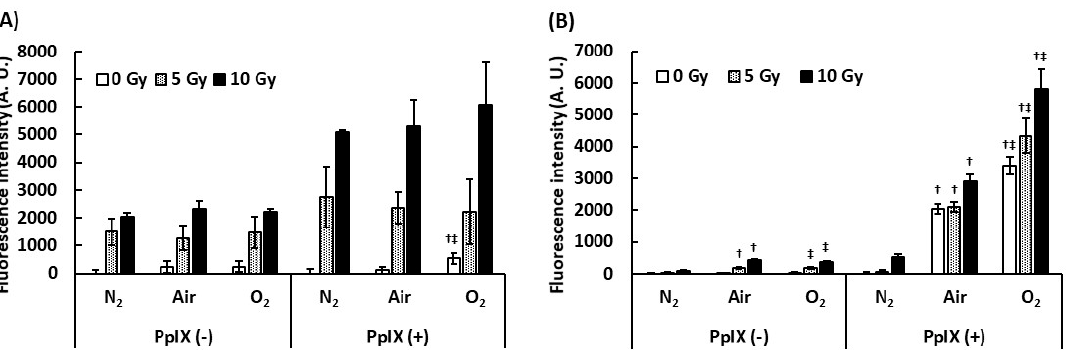
Figure 2. Effect of dissolved oxygen on ROS generation by the interaction between PpIX and X-ray. The PpIX mixture was bubbled by N 2 , air, and O 2 gas. ( A ) • OH measured by APF. ( B ) O 2 • - measured by DHE. (Data given with n = 6, † : p < 0.01 vs. the same X-ray dose (Gy) under the N 2 gas bubbling condition, ‡ : p < 0.01 vs. the same X-ray dose (Gy) under the air bubbling condition in a one-way ANOVA and Tukey post-test)